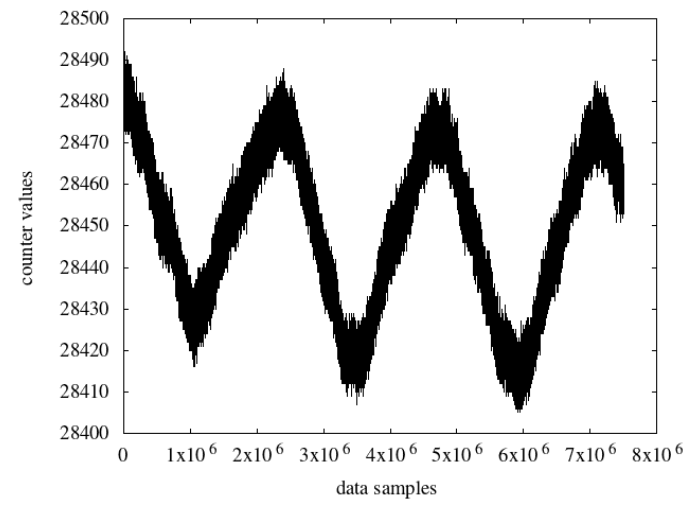
Figure 14: Counter values acquired using an external oscillator for s